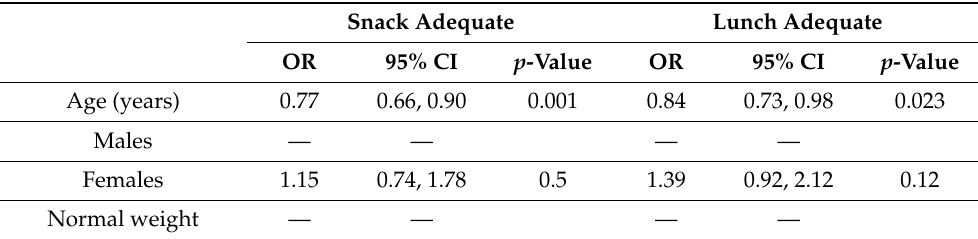
Table 3. Logistic regression